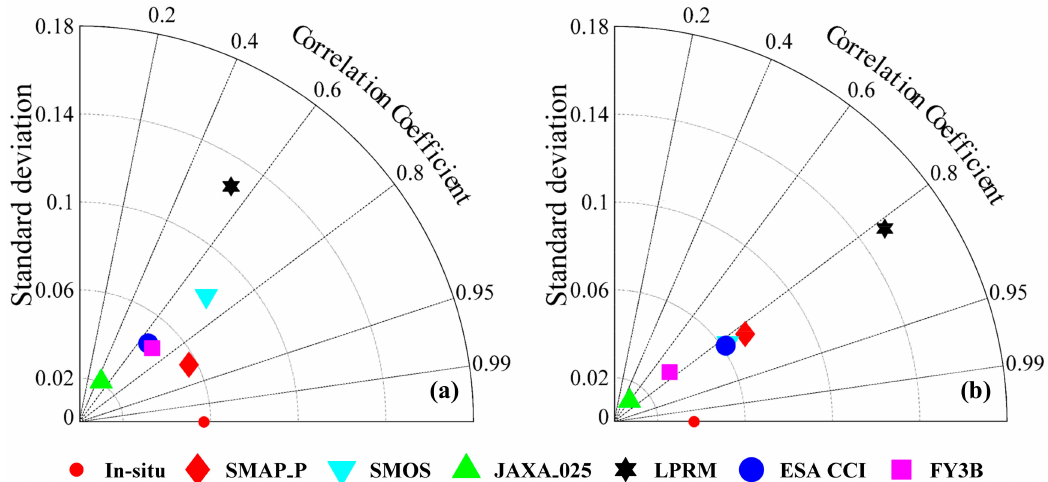
Figure 5. Taylor diagram illustrating the statistics of the comparison between station-averaged soil moisture and satellite soil moisture, with a spatial resolution of 0.25 ◦ , for the ( a ) LWW and ( b ) REMEDHUS networks.